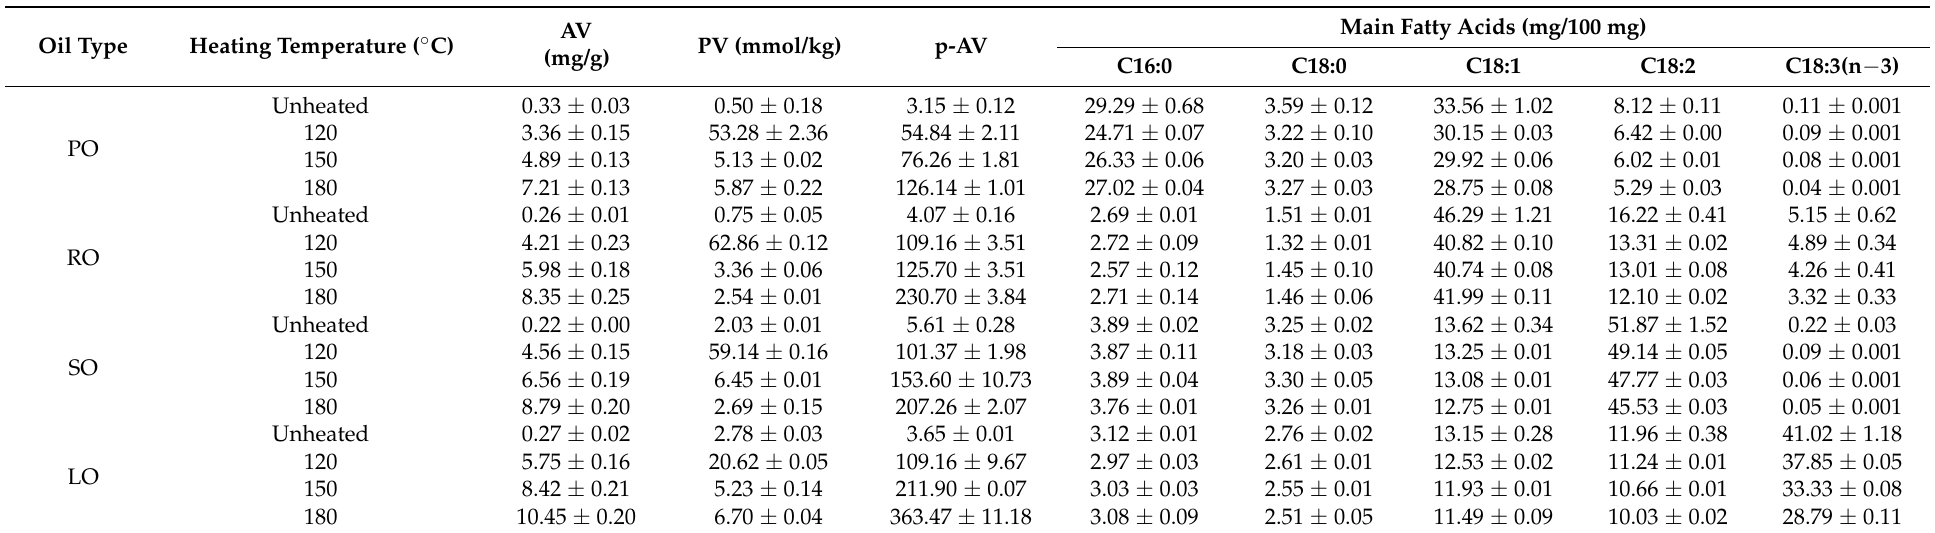
Table 2. AV, PV, p-AV and main fatty acid composition of four vegetable oils heated for 36